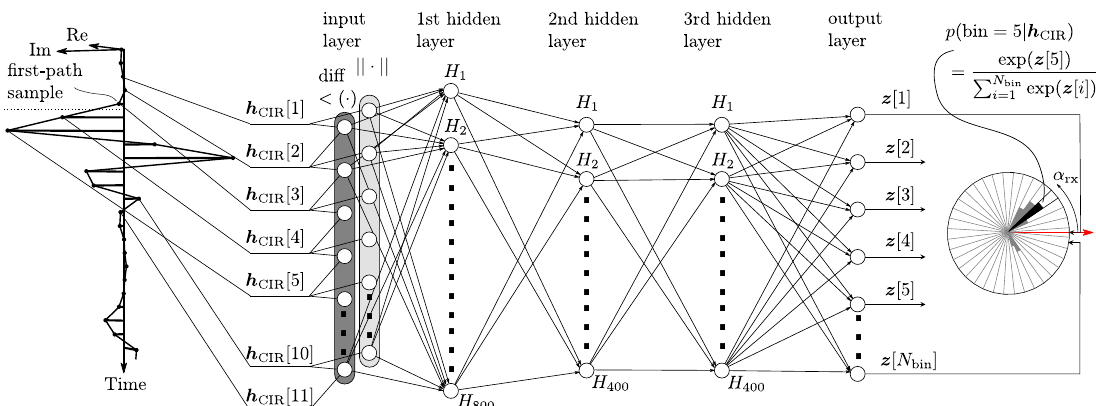
Figure 4. A standard neural network with three hidden layers is used to predict the AOA based on a window of the complex CIR envelope, starting two samples before the first path sample and ending eight samples after the first path sample. The magnitude and the phase differences of these eleven samples are fed to the input layer of the neural network. The outputs of the neural network are the unnormalized log probabilities of an AOA corresponding to a certain